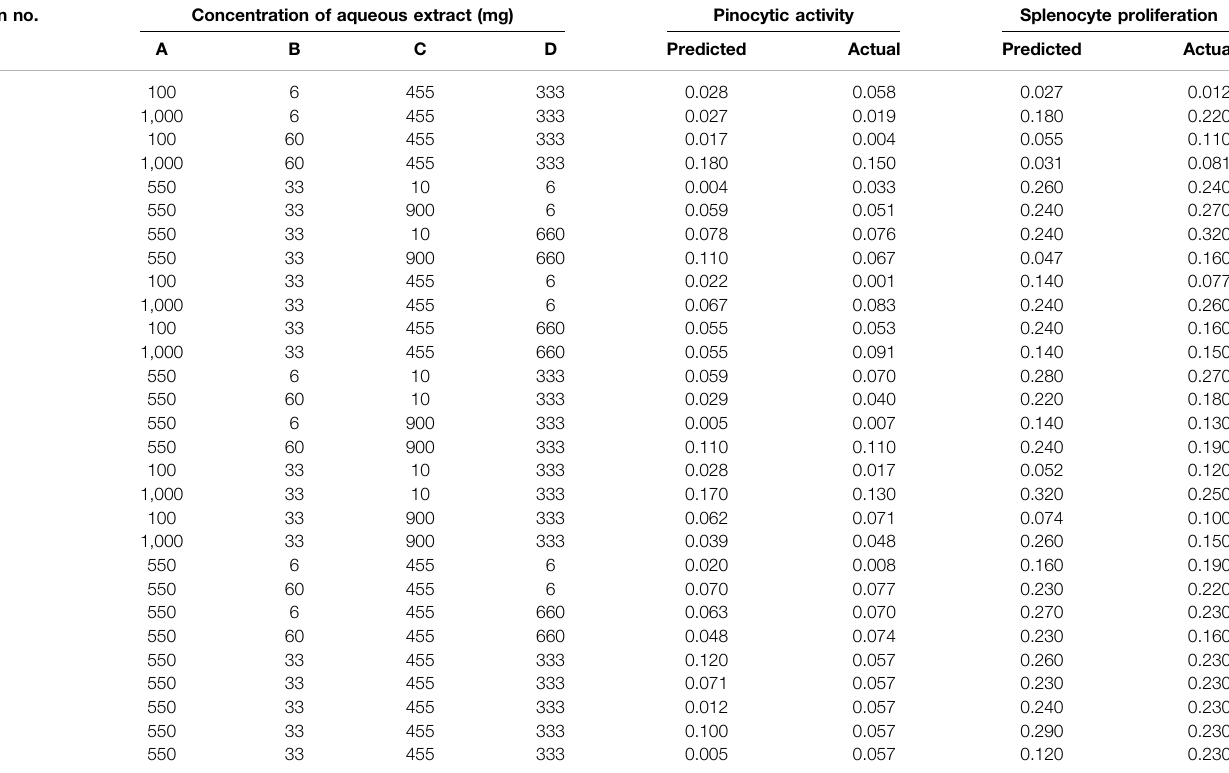
TABLE 1 | Four-variable Box – Bhenken design with experimental and predicted values of pinocytic and splenocyte proliferation of different combinations of aqueous extracts. Run